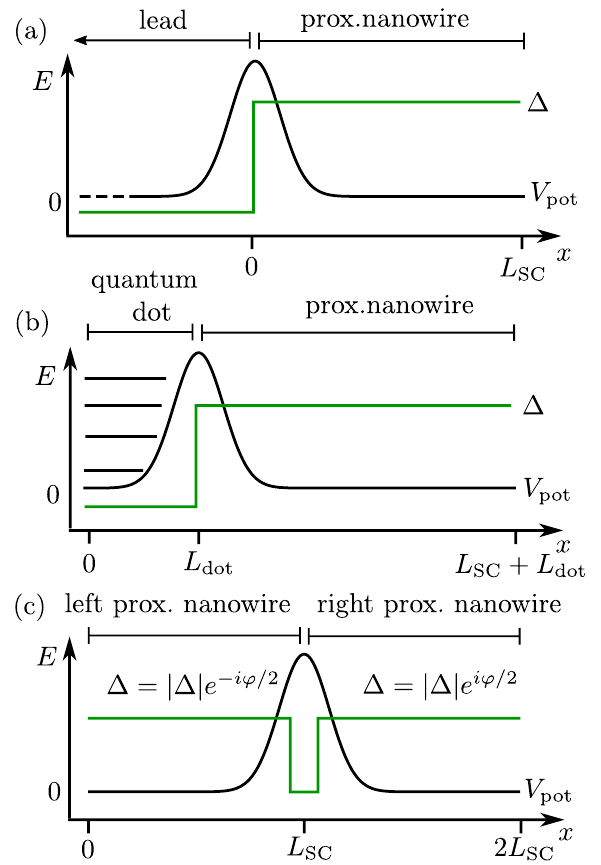
Figure 2: Schematic drawings of the three studied devices. The black lines indicate ( x ) , the green lines the superconducting gap ∆ ( x ) . (a): the potential profile V pot Proximitized nanowire of length L with constant superconducting gap ∆ connected SC to a semi-infinite normal lead from the left via a potential barrier. (b): Proximitized nanowire of length L connected to a normal quantum dot of length L SC via a potential barrier V . (c): Two finite proximitized nanowires, both of length pot L , with a superconducting phase difference ϕ between them, and separated by a SC potential barrier V pot